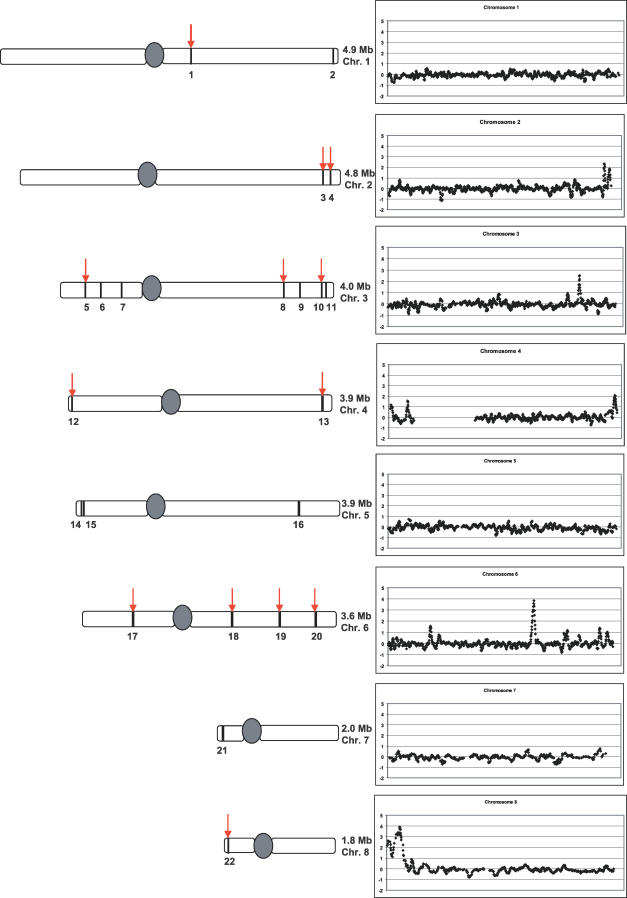
Positional Bias of LaeA-Regulated Gene ExpressionLeft, chromosomes of A. fumigatus with secondary metabolite gene clusters indicated as bars and clusters numbered as indicated in Table 2. Arrows indicate clusters that are completely or partially regulated by LaeA. Graphs to the right of each chromosome show normalized expression ratio values of ΔlaeA versus wild-type plotted by chromosomal position. Each point represents the average value of ten contiguous loci. The gap on Chromosome 4 indicates a region of the genome not included in the microarray that contains the rRNA gene cluster. Positive values correspond to reduced expression in ΔlaeA and negative values correspond to increased expression in ΔlaeA.